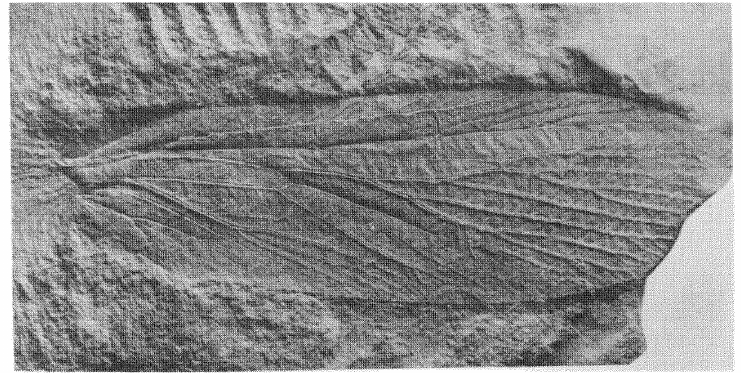
Fig. 19. Gerarus bruesi, photograph of holotype no. IP 20. Length of fore wing 45 mm, as preserved.